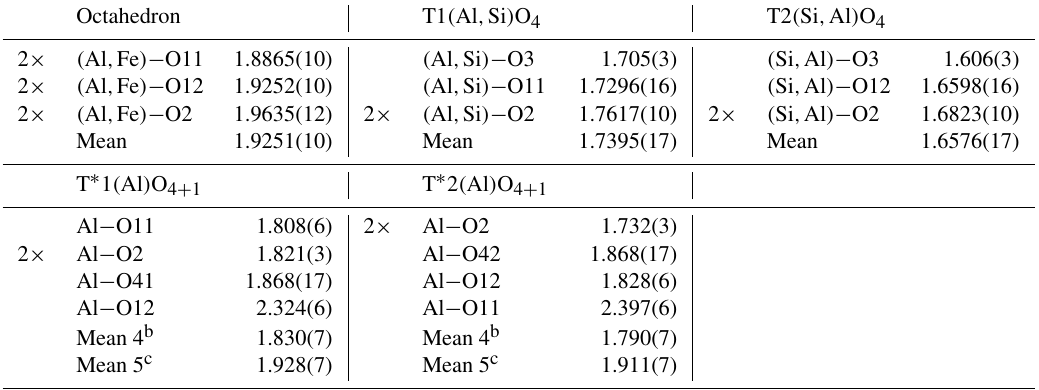
Table 4. Selected interatomic distances (Å) and mean a distances (Å) of mullite-2 c . Octahedron T1 ( Al , Si ) O 4 T2 ( Si , Al ) O 4